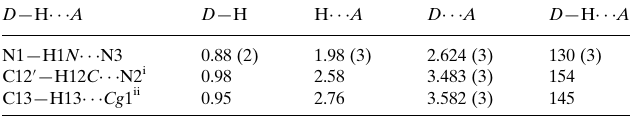
Hydrogen-bond geometry (A˚ , (cid:2) ). Cg 1 is the centroid of the C3–C8